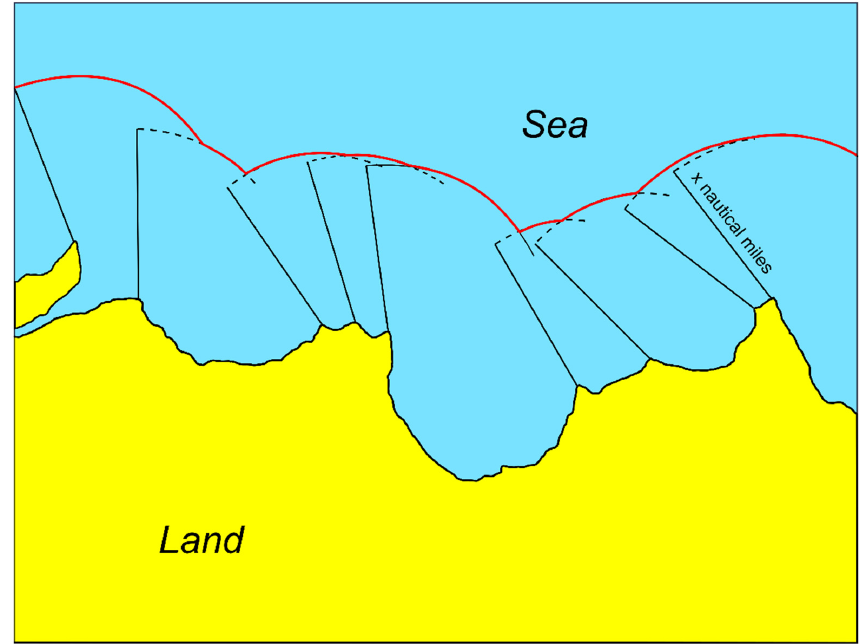
Figure 3. Delineating the outer limits of maritime zones through an envelope of arcs [4].